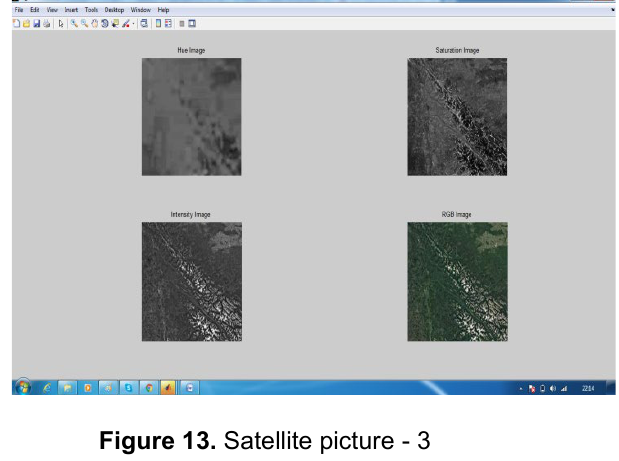
Figure 13. Satellite picture - 3